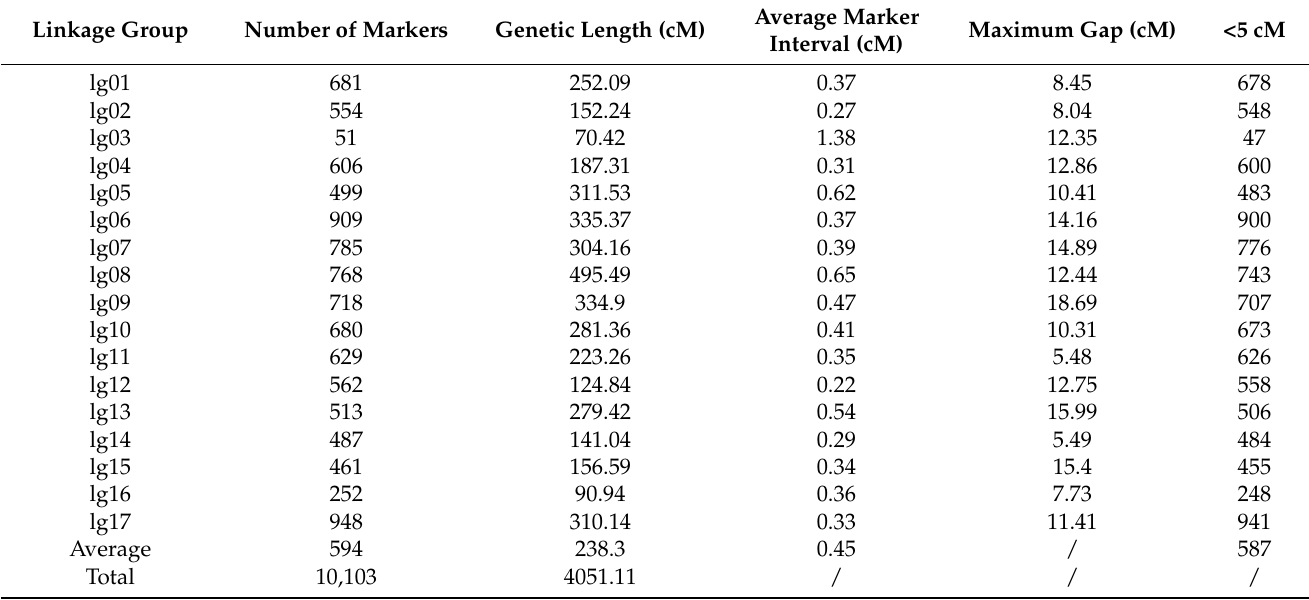
Note: <5 cM indicates the number of genetic distances between markers less than 5 cM.